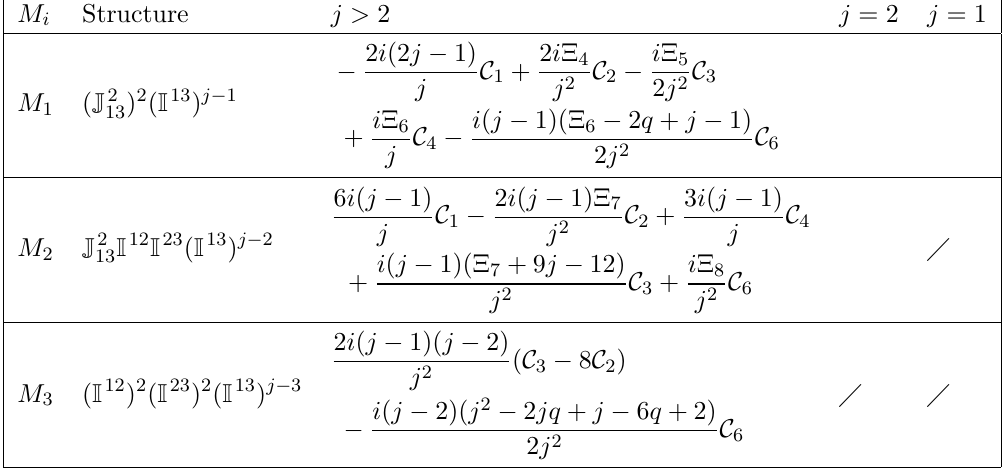
Table 23 . Expansion of the supersymmetric correlator in the component has spin (0 ; 1 ( j 1)) and QO has spin ( 1 2 (cid:0) identical and the ones in the j = 1 column are obtained by setting